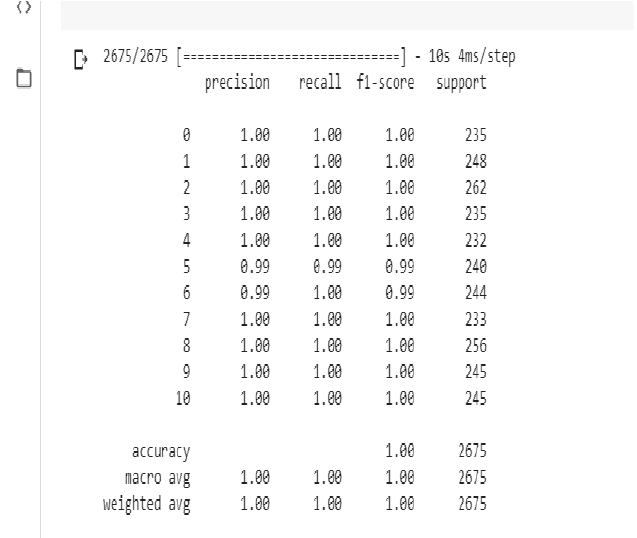
Figure 15. To find f1 score (accuracy)